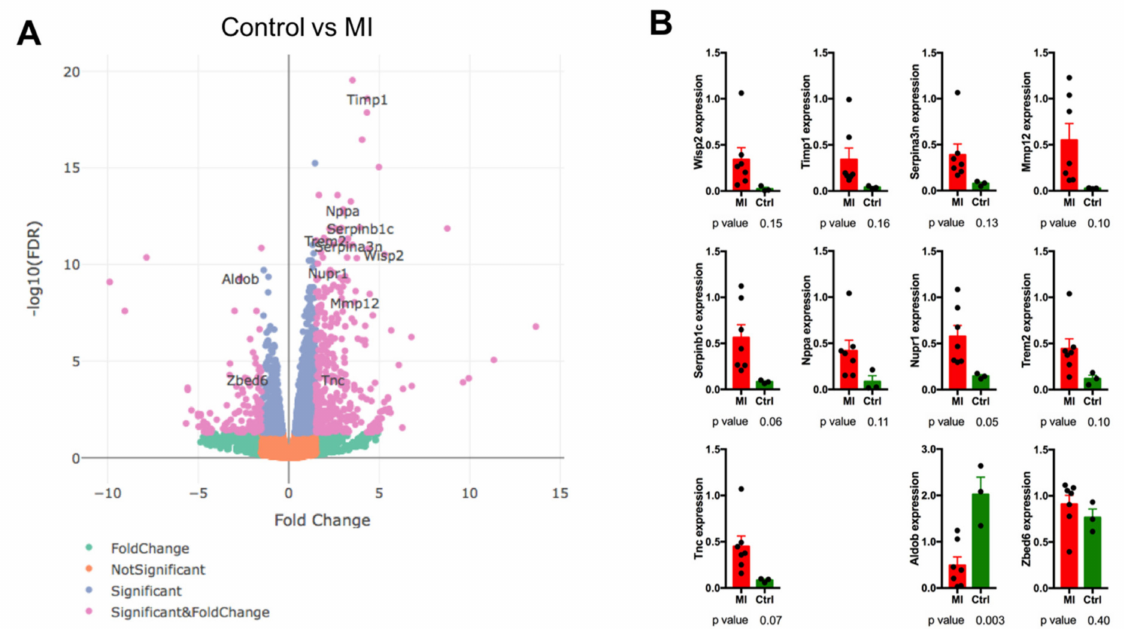
Figure 2. Analysis of expression profile in control vs. stable MI group. ( A ) A volcano plot of up- and down-regulated genes with genes of particular interest marked. RNAseq analysis was performed using following criteria: p < 0.01; − 2 > logFC > 2; only RNA targets with known/predicted function; minimal prevalence for target gene in the sample with higher expression = 100 reads (of 75 bp each). ( B ) Confirmation of expression in PET/CT group of mice using RNAseq. All results have been normalized to GAPDH expression. Dots represent particular samples, while bars represent mean ± SD. p -values ≤ 0.1 were considered to be